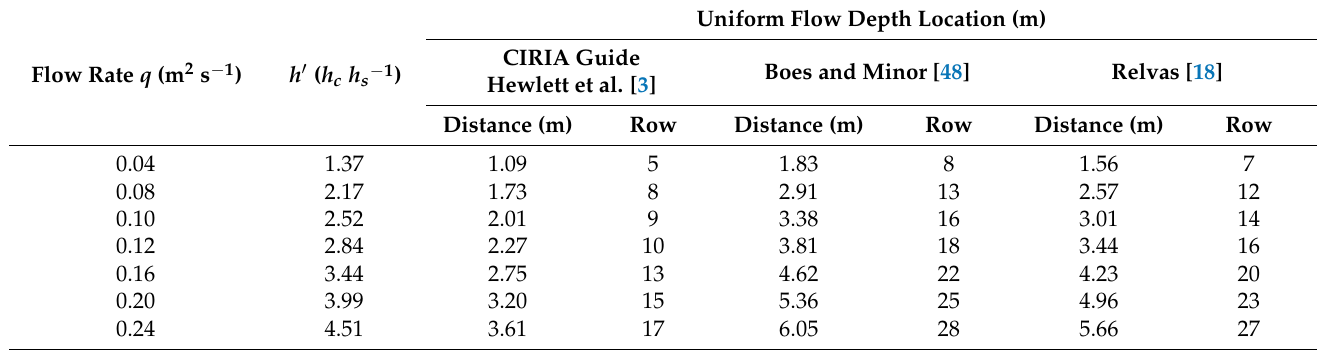
Table 3. The uniform flow depth location (distance and row) of tested flows according to different authors. Uniform Flow Depth Location Flow Rate q (m 2 s − 1 ) h (cid:48) ( h c h s − 1 )